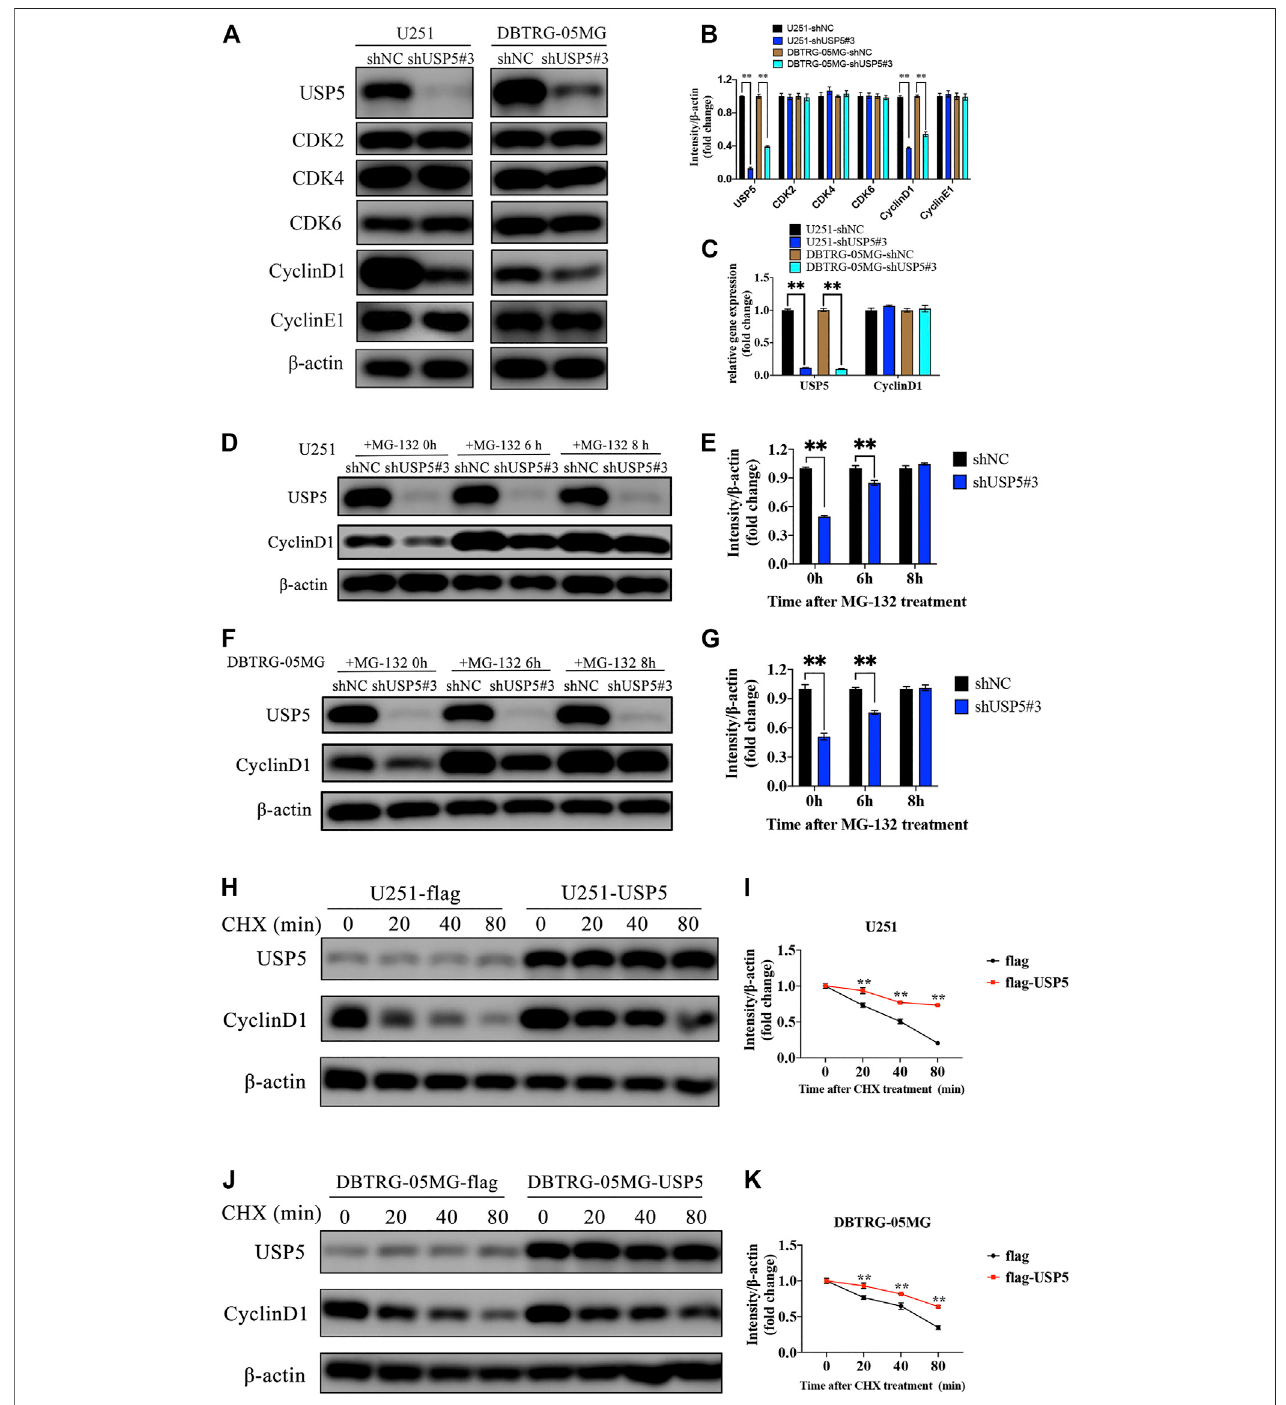
FIGURE 3 | USP5 maintained CyclinD1 stability (A, B) Western blotting analysis of USP5, CDK2, CDK4, CDK6, CyclinD1, CyclinE1, and β -actin protein levels in U251 and DBTRG-05MG cells stably expressed shNC or shUSP5#3 treated with 2 ug/mL Dox for 72 h (C) Real-time PCR analysis of USP5 and CyclinD1 mRNA levels inU251andDBTRG-05MGcellsstablyexpressedshNCorshUSP5#3treatedwith2 ug/mLDoxfor72 h (D – G) U251andDBTRG-05MGcellsstablyexpressed shNC or shUSP5#3 treated with 2 ug/mL Dox for 72 h were incubated with 20 μ M MG-132 for indicated time points. Western blotting analysis of USP5, CyclinD1, and β -actin protein levels (H – K) U251 and DBTRG-05MG cells stably expressed empty vector ( fl ag) or USP5 overexpression ( fl ag-USP5) were incubated with 100 μ g/ml CHX for indicated time points. Western blotting analysis of USP5, CyclinD1, and β -actin protein levels (Data were presented with mean ± SD of three independent experiments, * p < 0.05, ** p <